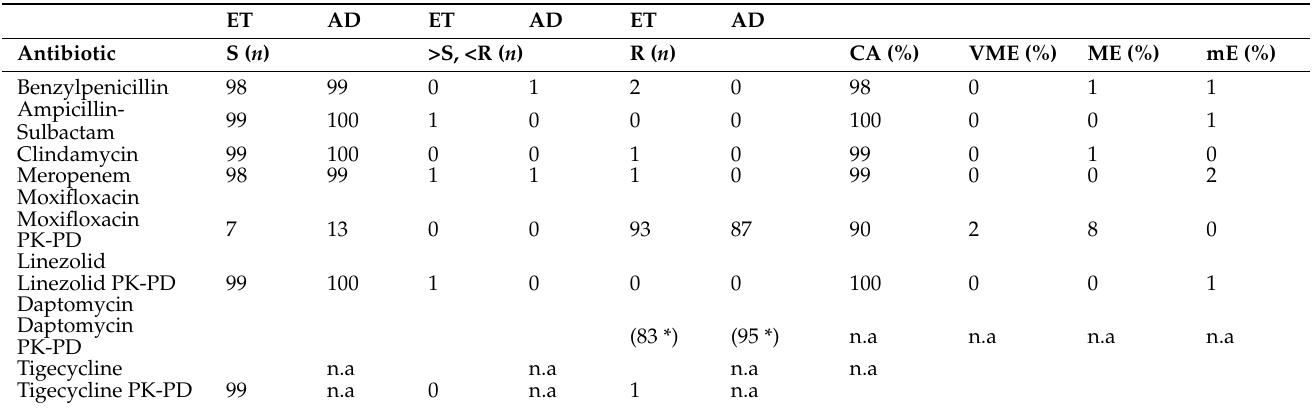
Table 1. Number of susceptible (S), reduced susceptible (>S, <R) and resistant (R) Actinomyces spp. isolates against eight antimicrobial agents tested by the E-Test (ET) and agar dilution (AD) methods, using EUCAST breakpoints or ECOFFS